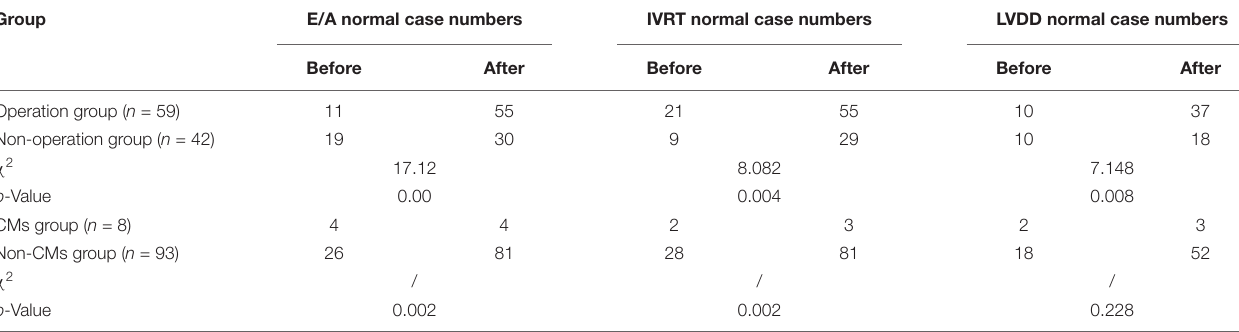
TABLE 7 | Cardiac diastolic function evaluation of DHF patients before and after therapies.